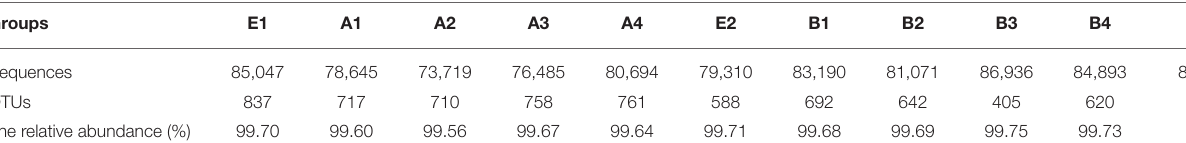
TABLE 7a | Date statistics of sample gene sequences.